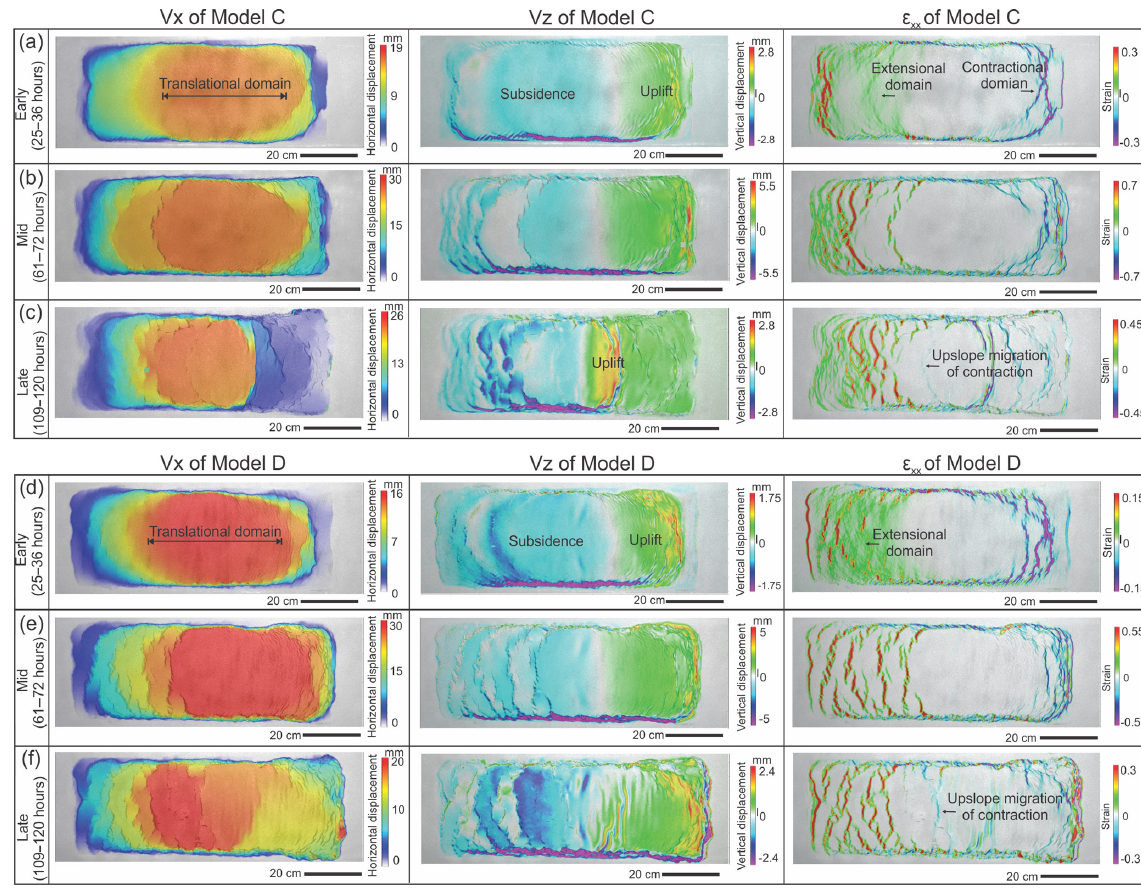
Figure 6. ( a – c ) Map view of incremental horizontal and vertical displacement ( V x , V z ) and strain pattern ( ε xx ) derived from 3-D DIC strain data of Model C from the (a) early (25–36h), (b) middle (61–72h) and (c) late stages (109–120h). Note the upslope migration of the translational domain and its overprinting at the end of the experiment. ( d – f ) Map view of incremental horizontal and vertical displacement ( V x , V z ) and strain pattern ( ε xx ) of Model D from the (d) early (25–36h), (e) middle (61–72h) and (f) late stages (109–120h). Note the widely distributed deformation and overprinted translational domain. The horizontal displacement ( V x ) displays downslope displacement of the sedimentary cover (left to right in map view). The vertical displacement ( V z ) displays total subsidence and uplift. The horizontal strain ( ε xx ) shows location of the extensional (red) and contractional (purple)